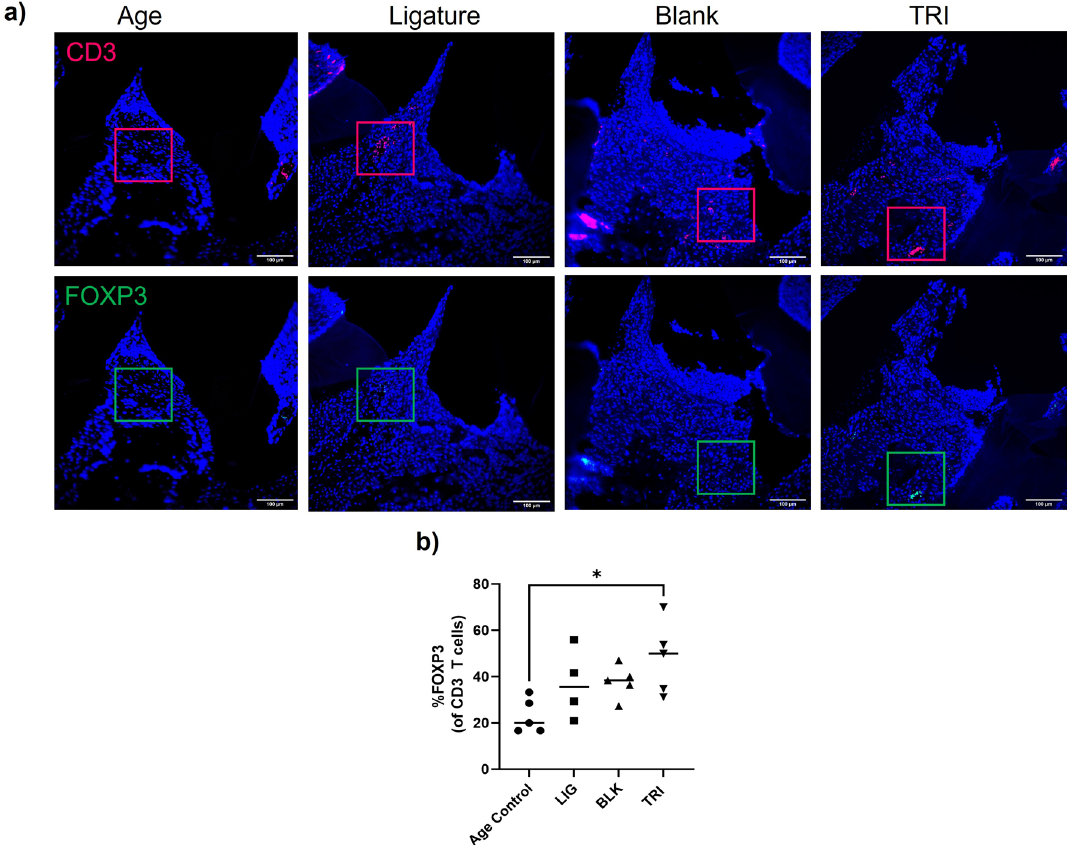
Figure 3. TRI MPs increase the local ratio of Tregs(FOXP3 positive cells). ( a ) Representative immunofluorescence staining for CD3 (total T cells), FOXP3 (Tregs), and DAPI (nuclei). Scale bars are 100 µm.